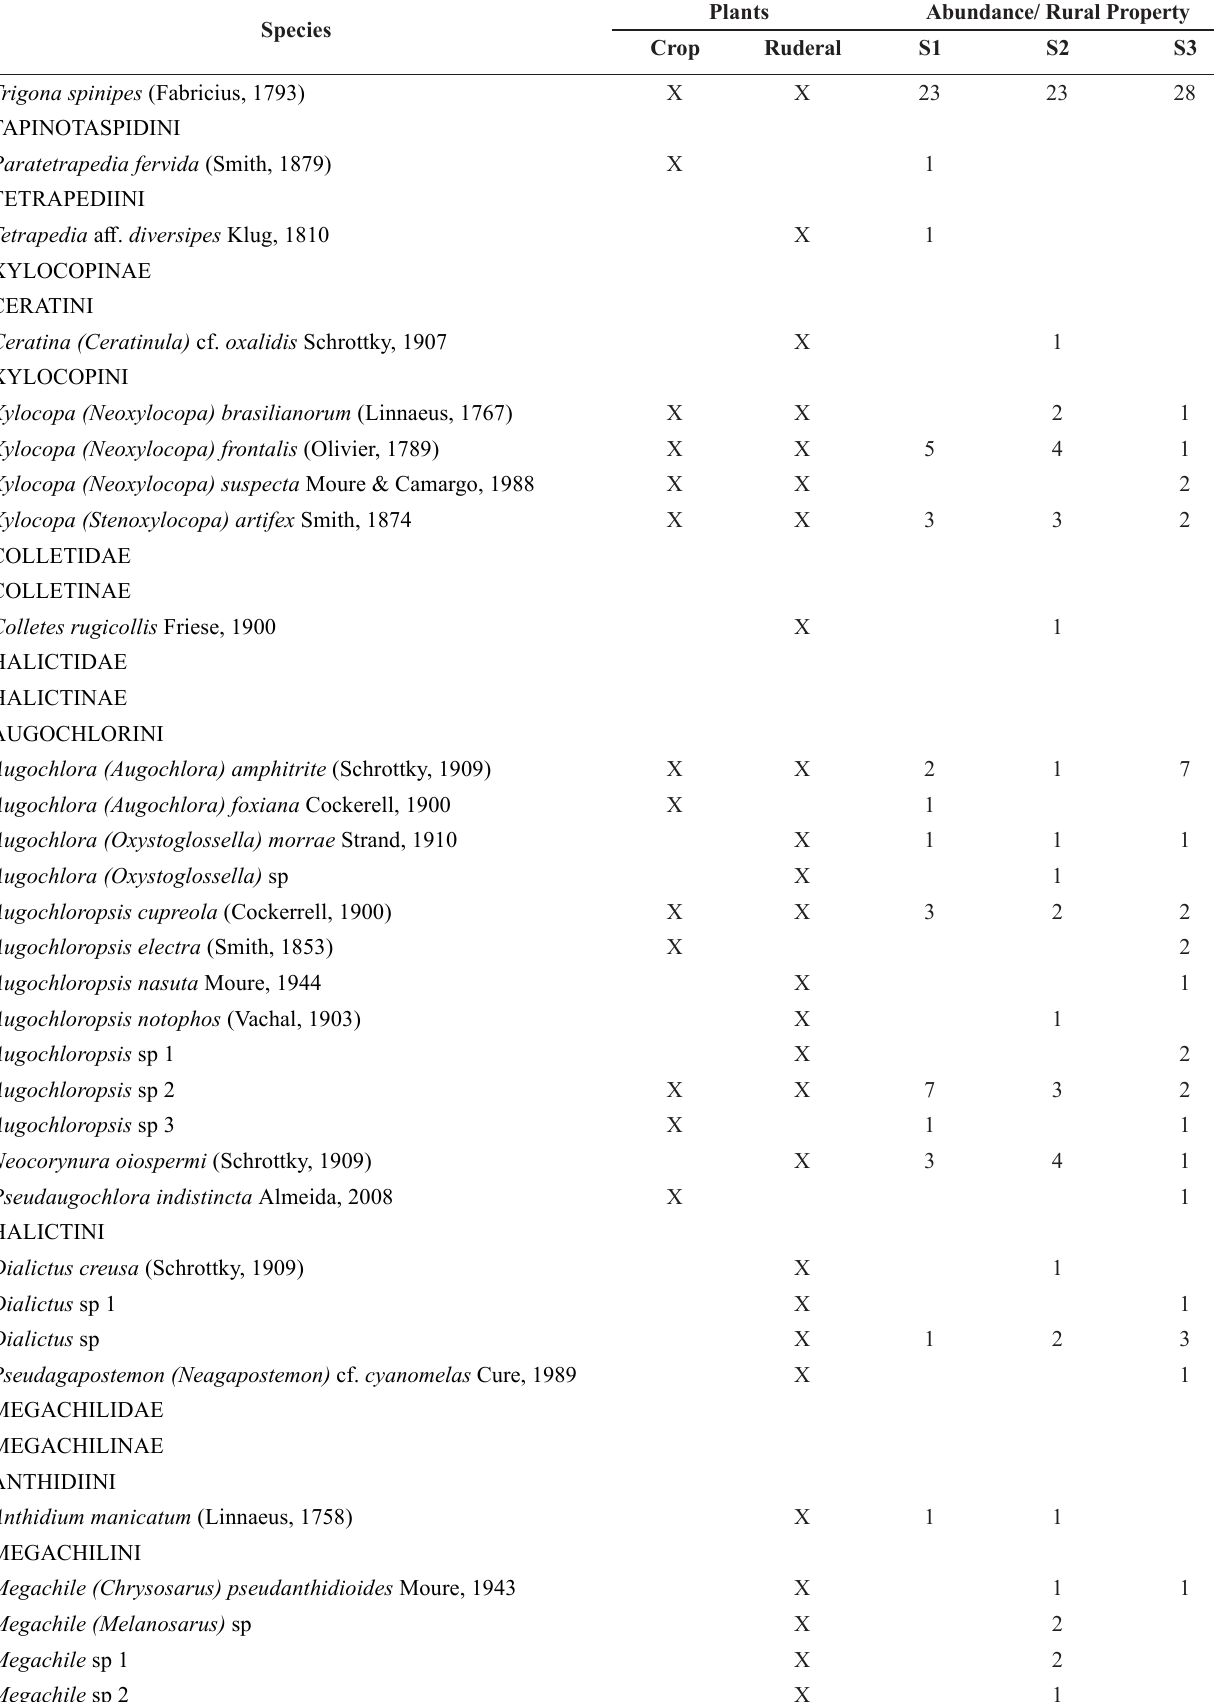
Table 2 . Bee species, abundance and type of plant visited at three smallholder rural properties in Guapiara, São Paulo state, Brazil, between May 2012 and March 2013.